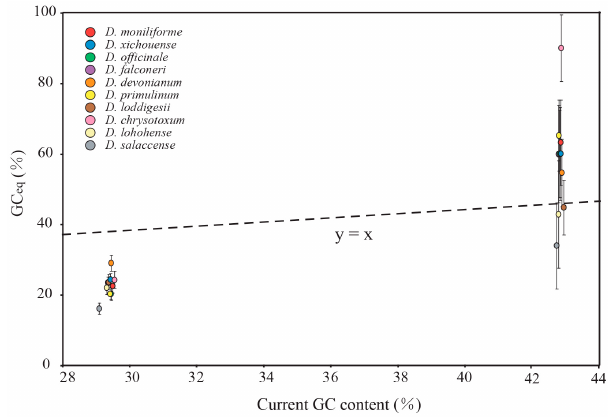
Figure 5. Comparison of equilibrium GC content (GC eq ) values between the SC and IR regions for the non-coding regions. Error bars depict 95% confidence intervals for GC eq . Note that, the non-coding regions showed contrast GC eq values (<50% in SC and >50% in IR) in SC and IR regions. Moreover, the estimated GC eq values are lower than current GC content in SC regions, but higher than current GC content in IR regions. Table 2. Summary of mutations in non-coding loci.